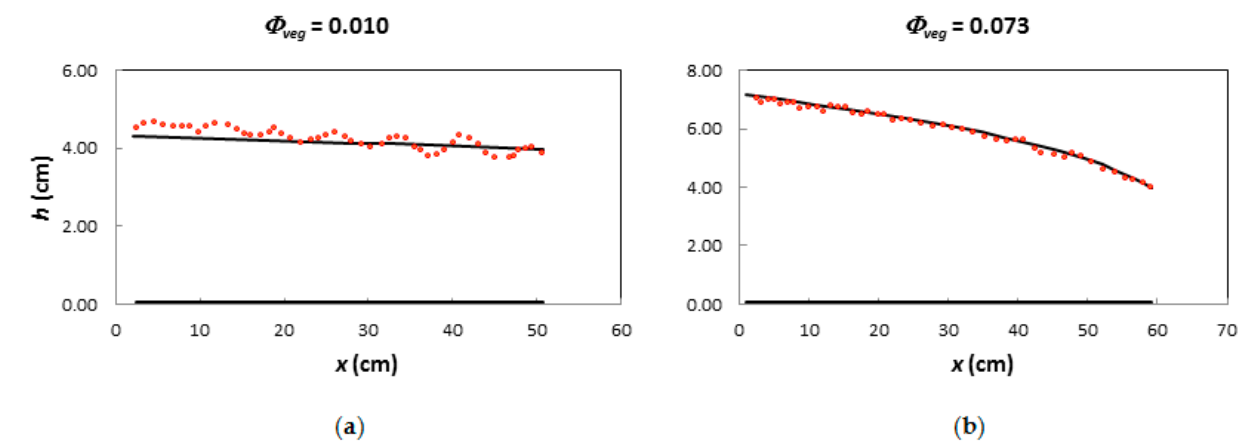
Figure 11. Comparison between two free surface profiles measured by Wang et al. [1] and the profiles calculated using C D − UC : ( a ) φ veg = 0.01; ( b ) φ veg = 0.073. The black bold line indicates the flume bottom; the black line is the calculated free surface; the red symbols indicate the measured free surface.